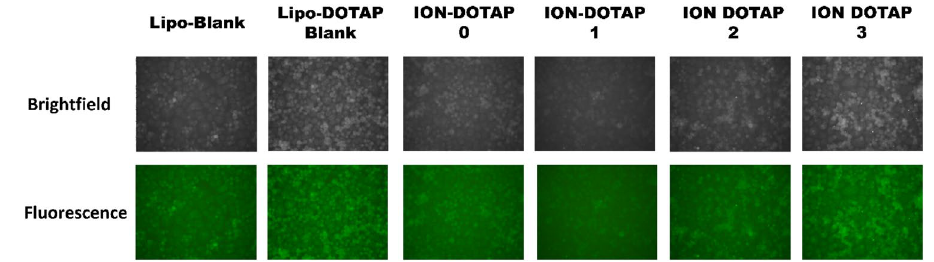
Figure 7. Photomicroscopy of cellular uptake of HeLa cells after incubation with β-ionone liposomes containing Coumarin-6 (in green color) prepared with various concentrations of DOTAP for two hours at 20 × magnification under a fluorescence microscope.